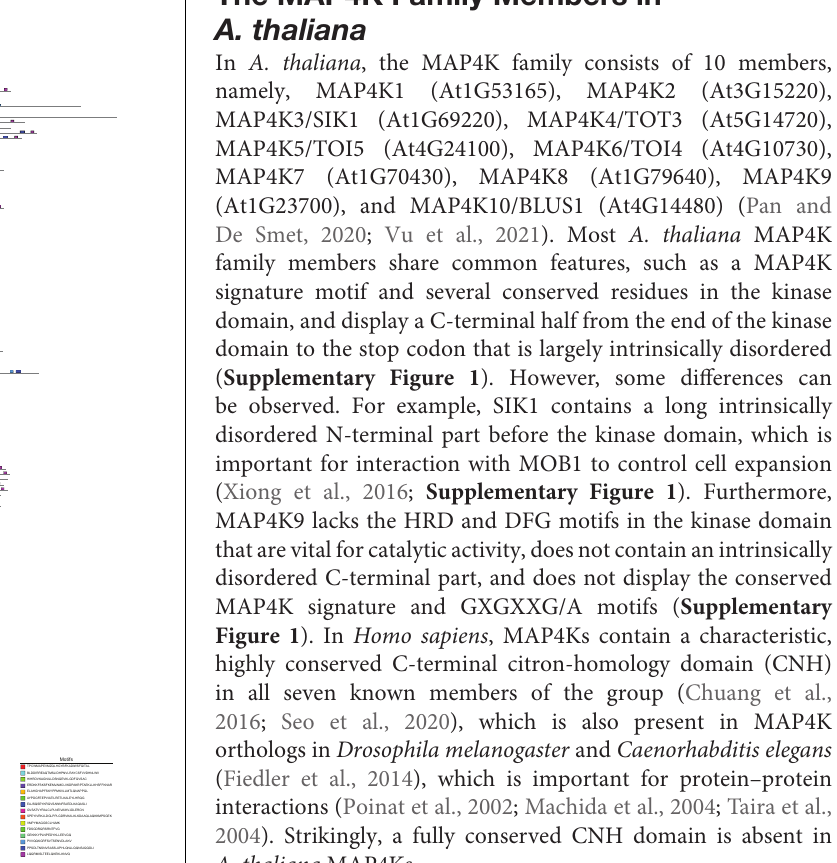
FIGURE 1 | Combined phylogenetic tree and motif locations of the green lineage MAP4Ks. (A) Inferred phylogenetic tree of putative green lineage mitogen-activated protein kinase MAP4Ks among representative species. The maximum likelihood tree was inferred from the multiple alignments of 239 putative MAP4K sequences and 10 previously described Arabidopsis thaliana MAP4Ks sequences across 34 Viridiplantae primary proteomes using IQ-Tree. Three main clades are indicated: I, II, and III. Clade III contains additional subclades. IIIA, IIIB, IIIC, and IIID. Bootstrap values > 24% are indicated